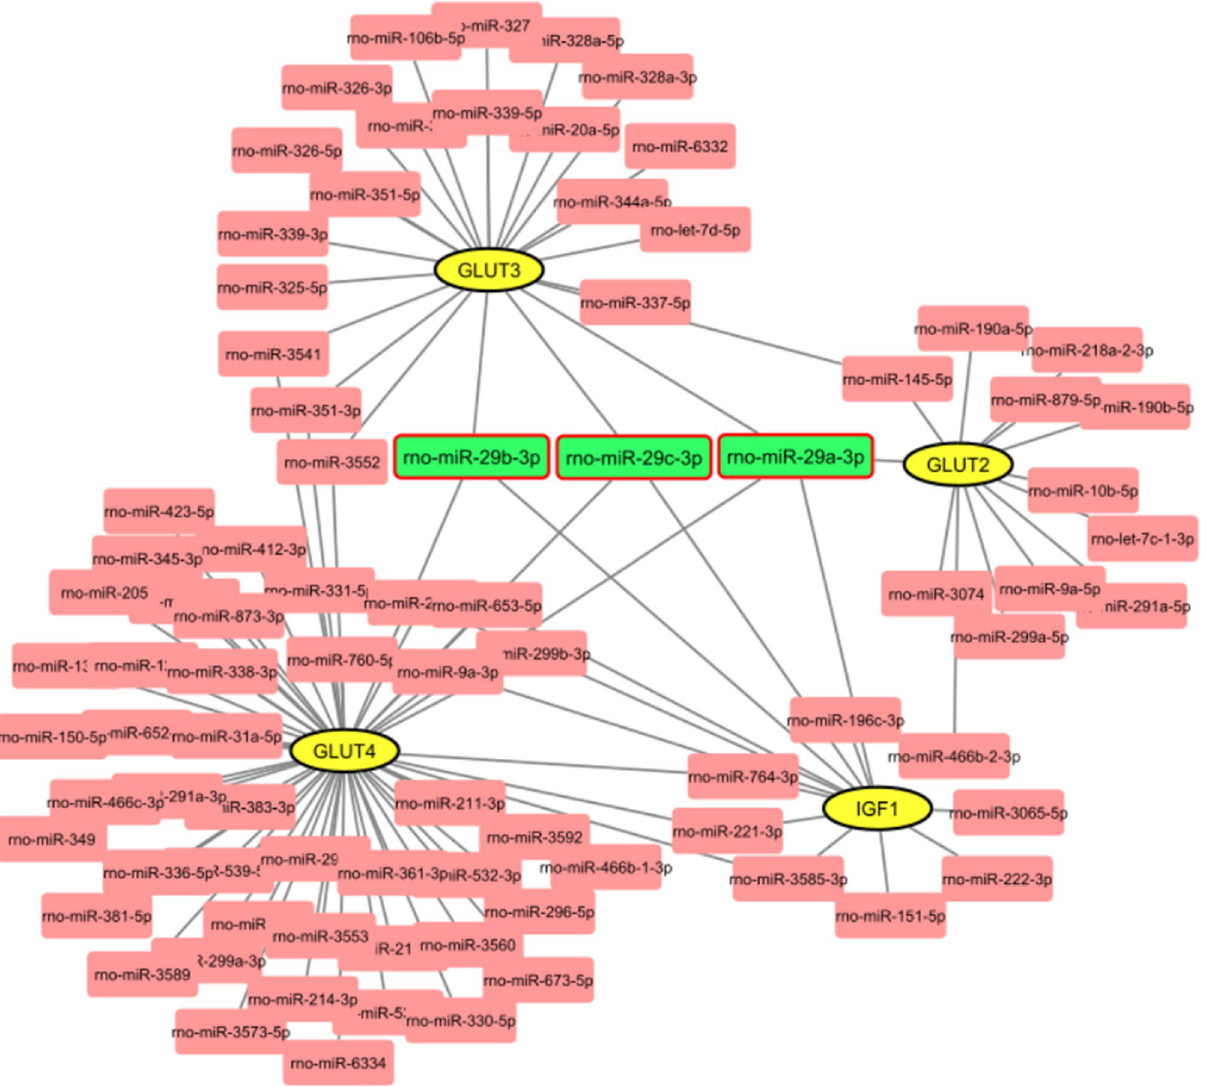
Figure 1. Potential regulation of glucose transporters and IGF-1 by miR-29 family. Among all miRNAs which target the GLUT1, 2, 3, 4, and IGF-1 genes, three members of the miR-29 family can target commonly all GLUT3, 4, and IGF-1 genes. GLUT2 is also targeted by miRNA-29a. Cityscape 3.8.0 (https:// cytos cape. org/ relea se_ notes_3_ 8_0. html) was used for network representation.